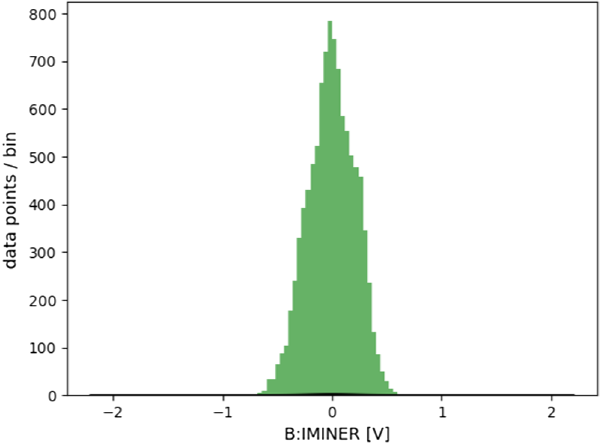
FIG. 2. Distribution of fractional measured error in the GMPS current at the minimum value of the magnet current (prefix B: indicates booster, I current, MIN miniumum, and ER error), with the non-ML PID regulator discussed in the text. From Ref.